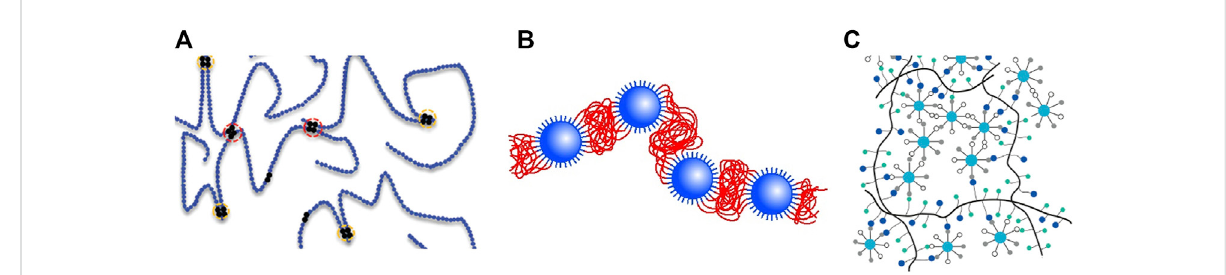
FIGURE 4 (A) Ideal case of NP connecting two polymer molecules by their chain ends (Gbadamosi et al., 2019); (B) Conceptual picture of nanoparticle linkingtwopolymer “ fl uffyglobules ” ,ratherthanchainelements; (C) Smallnanoparticlesservingasinter-molecularlinker,butalsoasintra-molecular associator (Cao et al.,